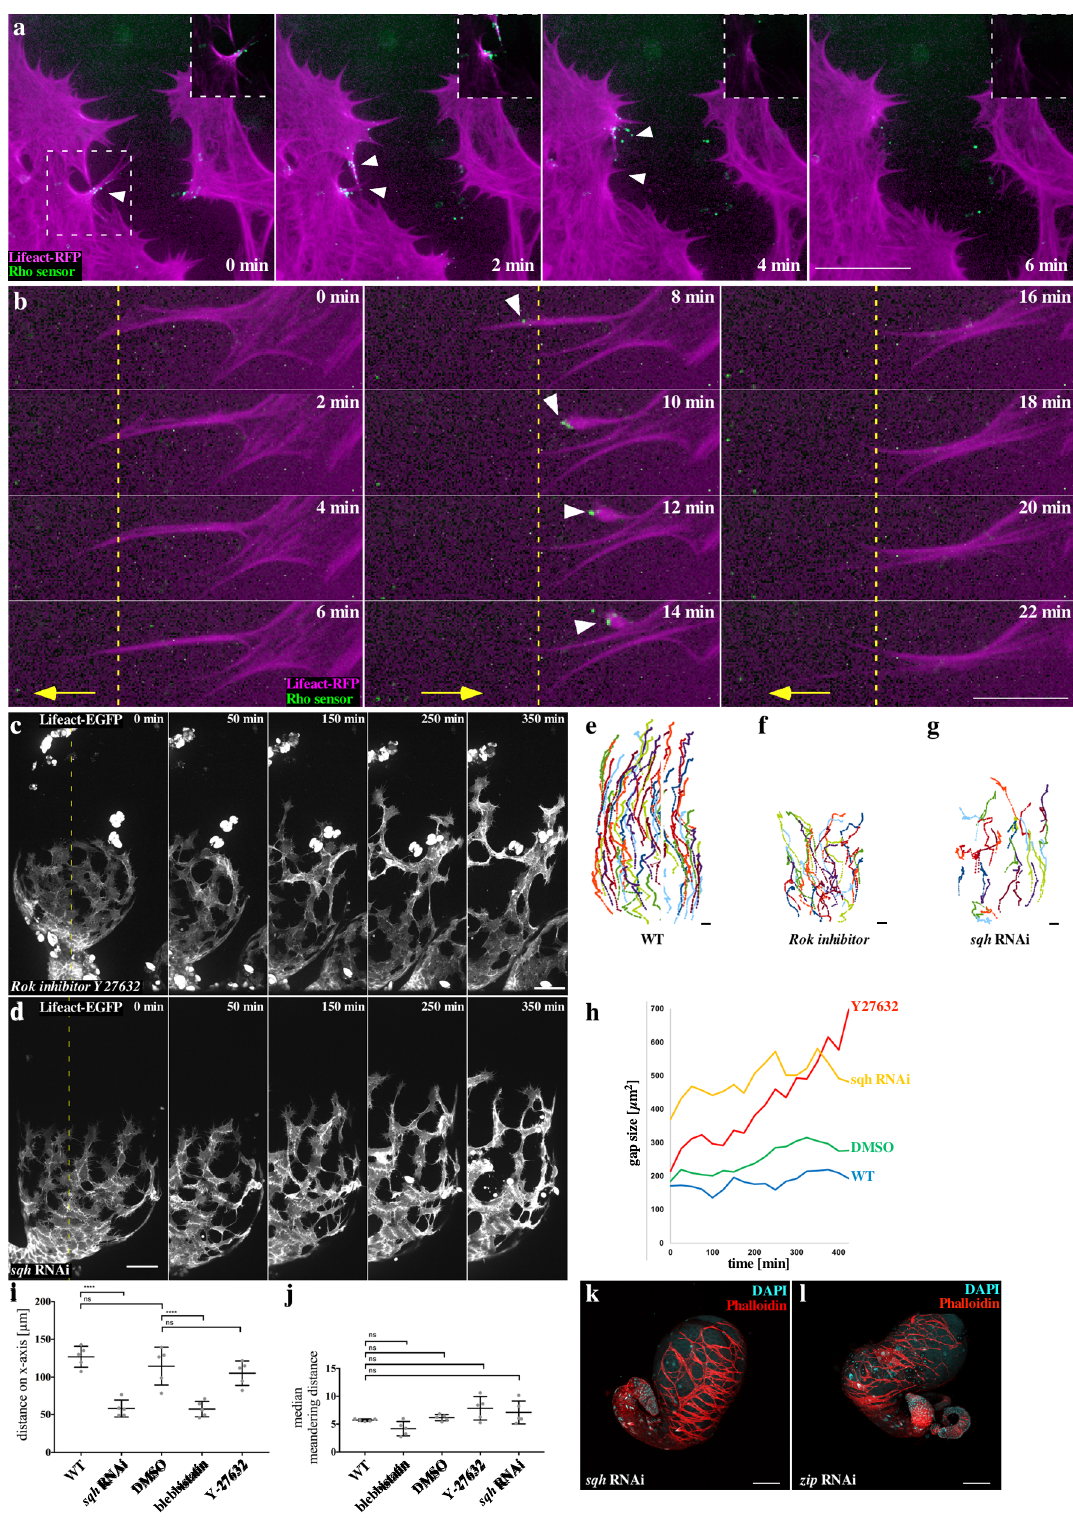
9.3 software. For drift correction, the reference frame module was used. The x - axis was positioned as axis from the genital disc to the testis hub. Excel was used for all processing and quanti fi cation. For more details see also Supplementary Dataset 1. Distance on x is de fi ned as the difference between the x values of the same track at t = 0 and t = 7 h on unprojected and unsmoothed 3D data. It was used as a measuring tool instead of speed, as fl uctuations in manual tracking strongly affects velocity especially in slow